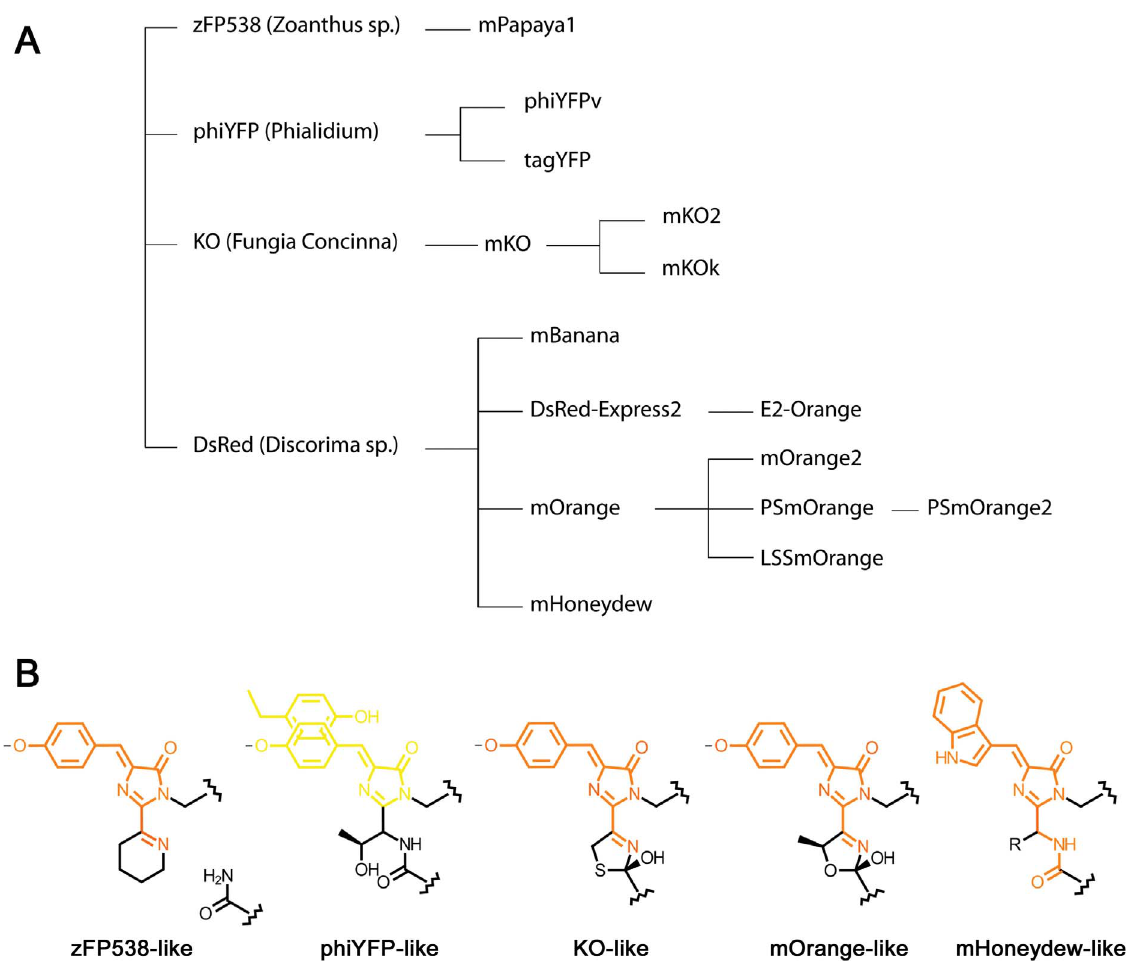
Figure 1. Evolution of the subfamily of orange fluorescent proteins. ( A ) Phylogenic tree showing the history of the development of different orange fluorescent proteins. ( B ) Chemical structures of the chromophores found in orange fluorescent proteins.